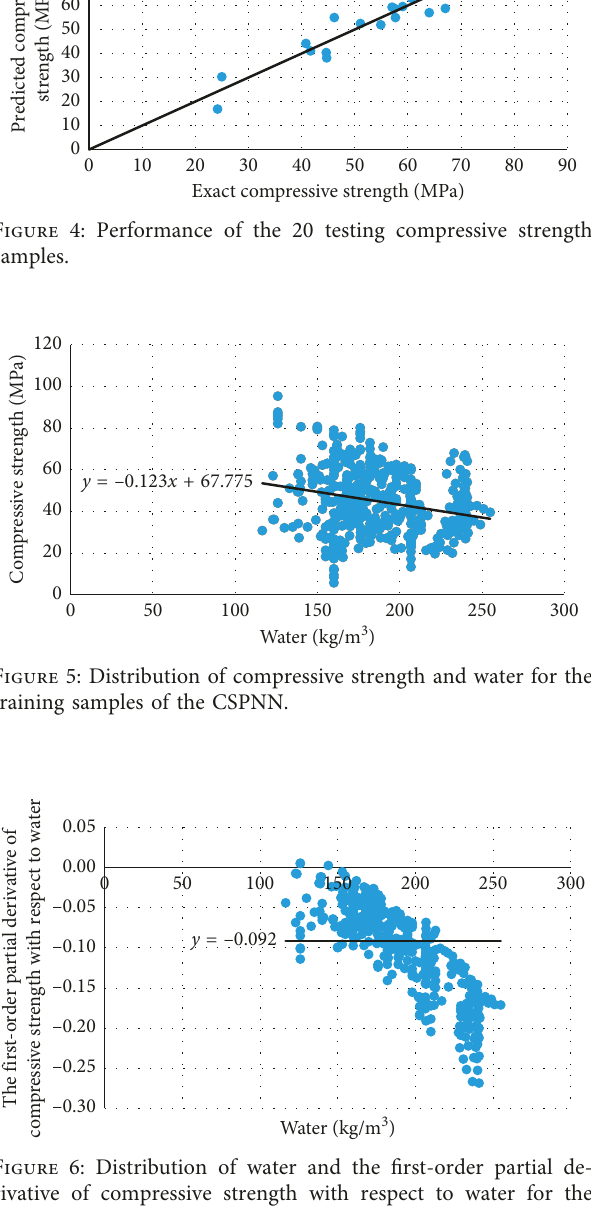
Figure 9: Distribution of compressive strength and SP for the training samples of the